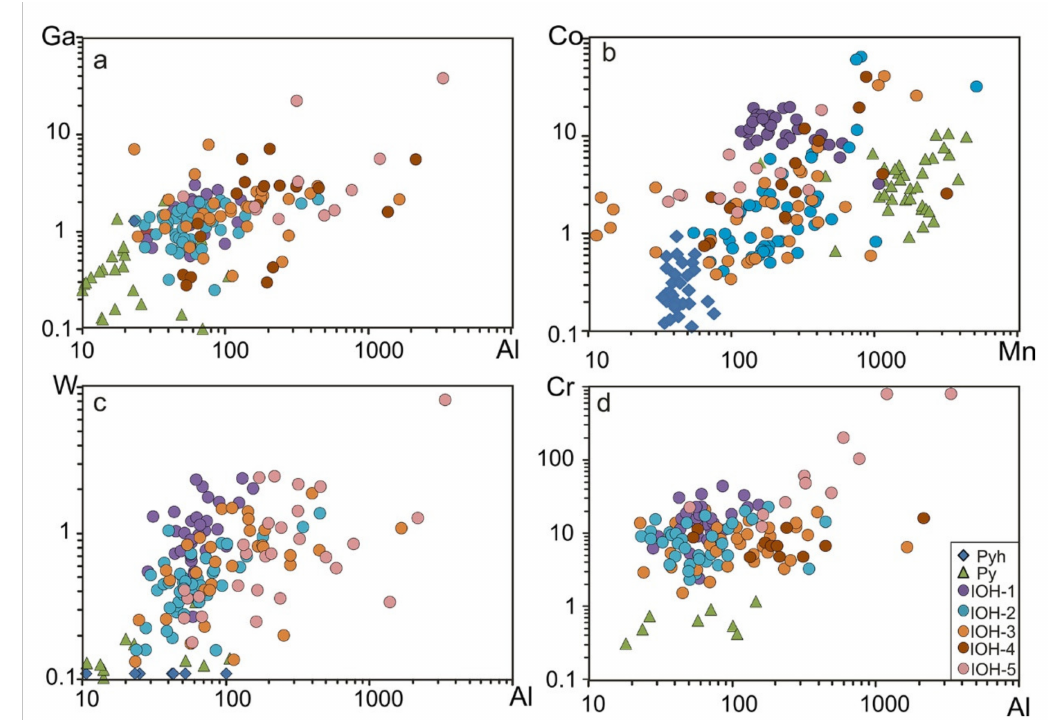
Figure 7. Bivariate plots of: ( a ) Al vs. Ga; ( b ) Mn vs. Co; ( c ) Al vs. W and ( d ) Al vs. Cr for the iron oxyhydroxides (IOH), pyrite (Py) and pyrrhotite (Pyh) of the Pobeda-1 hydrothermal field